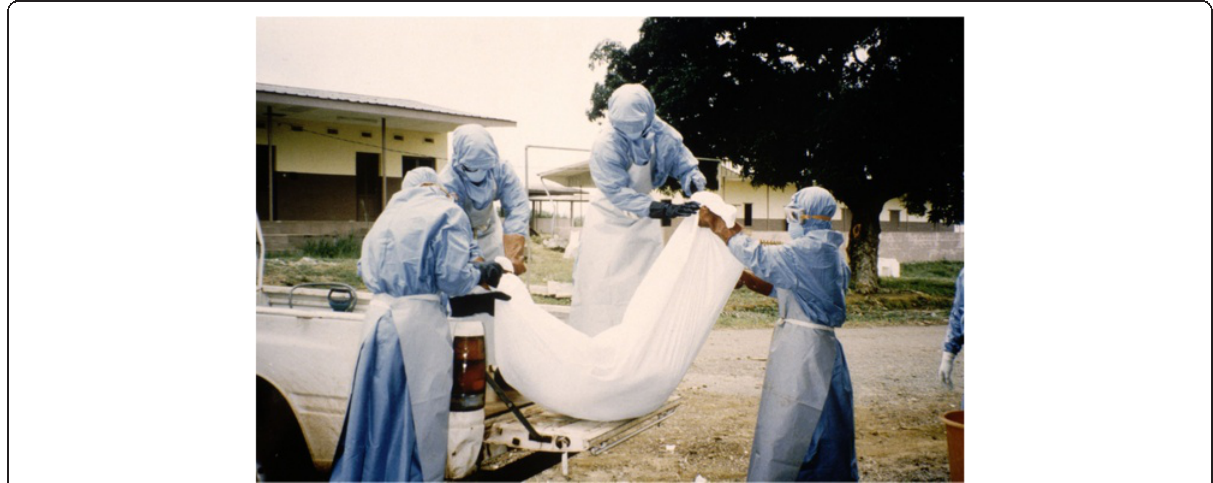
Figure 9 Boarding of a corpse in the vehicle for transportation to the burial site (photo by Jean-Paul Gonzalez, ©IRD).